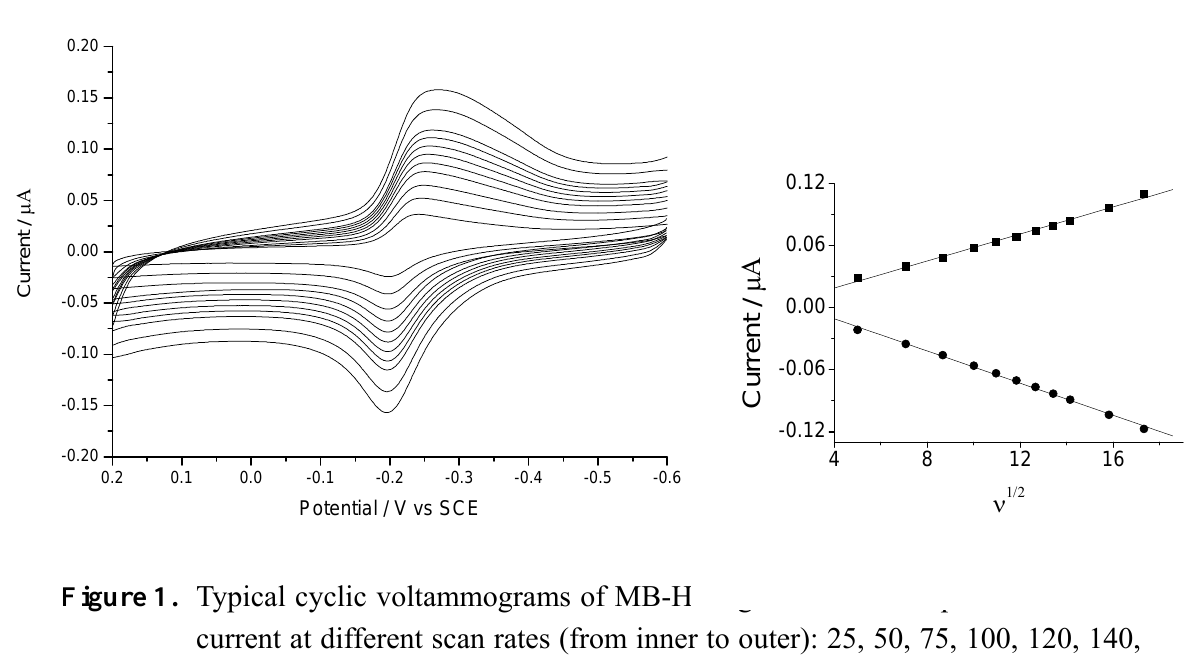
Figure 1. Typical cyclic voltammograms of MB-HRP/gelatine and the plot of the wave current at different scan rates (from inner to outer): 25, 50, 75, 100, 120, 140, 160, 180, 200, 250, 300